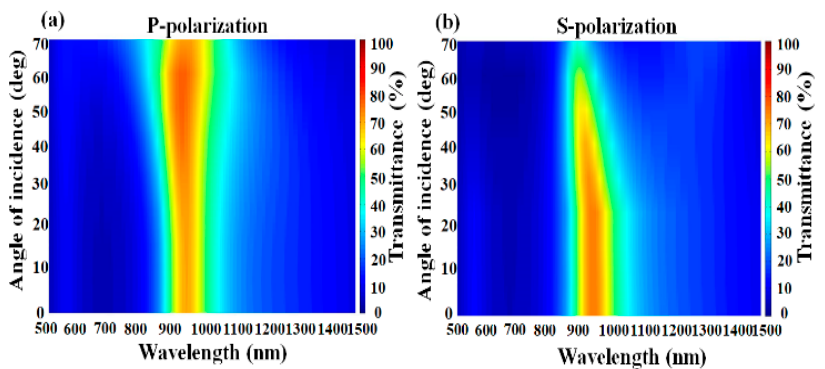
Figure 6. Measurement of ( a ) p-polarized and ( b ) s-polarized transmittances of deposited multilayer as functions of wavelength and angle of incidence.